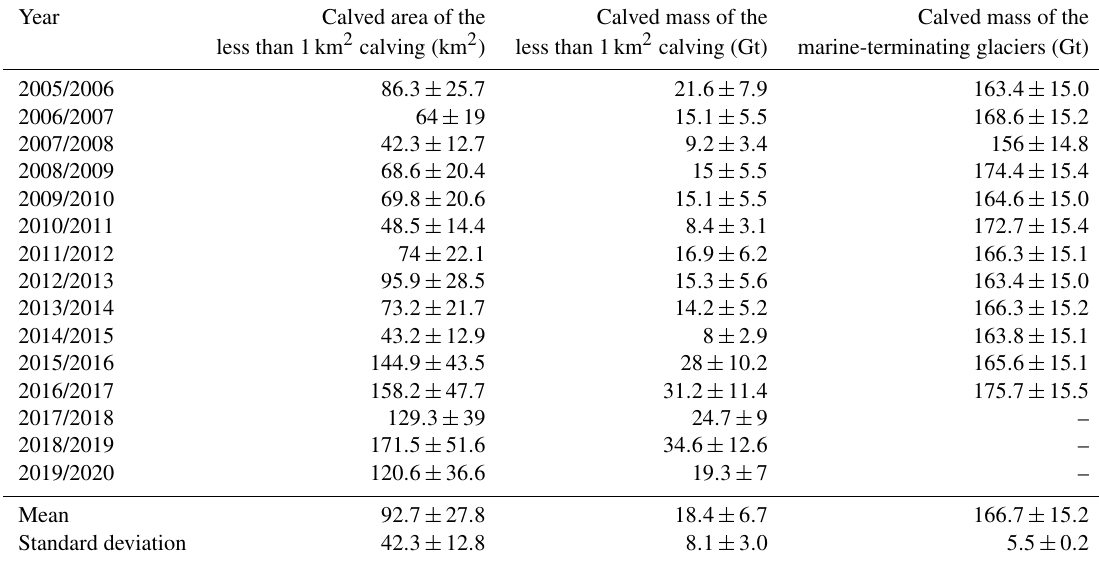
Table 6. Annual distribution of calved area and calved mass of the less than 1km 2 calving from the Antarctic ice shelves and the calved mass from the marine-terminating glaciers from August 2005 to August